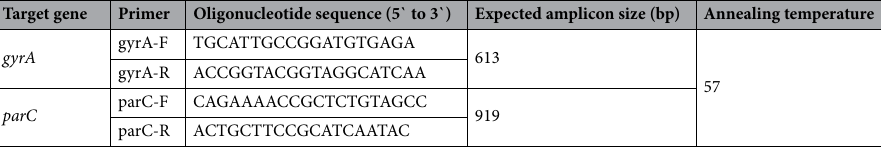
A. PCR screening of FQ-resistance target site mutation PCR condition denaturation at 95 °C for 2 min, then 35 cycles of amplification as follows: denaturation at